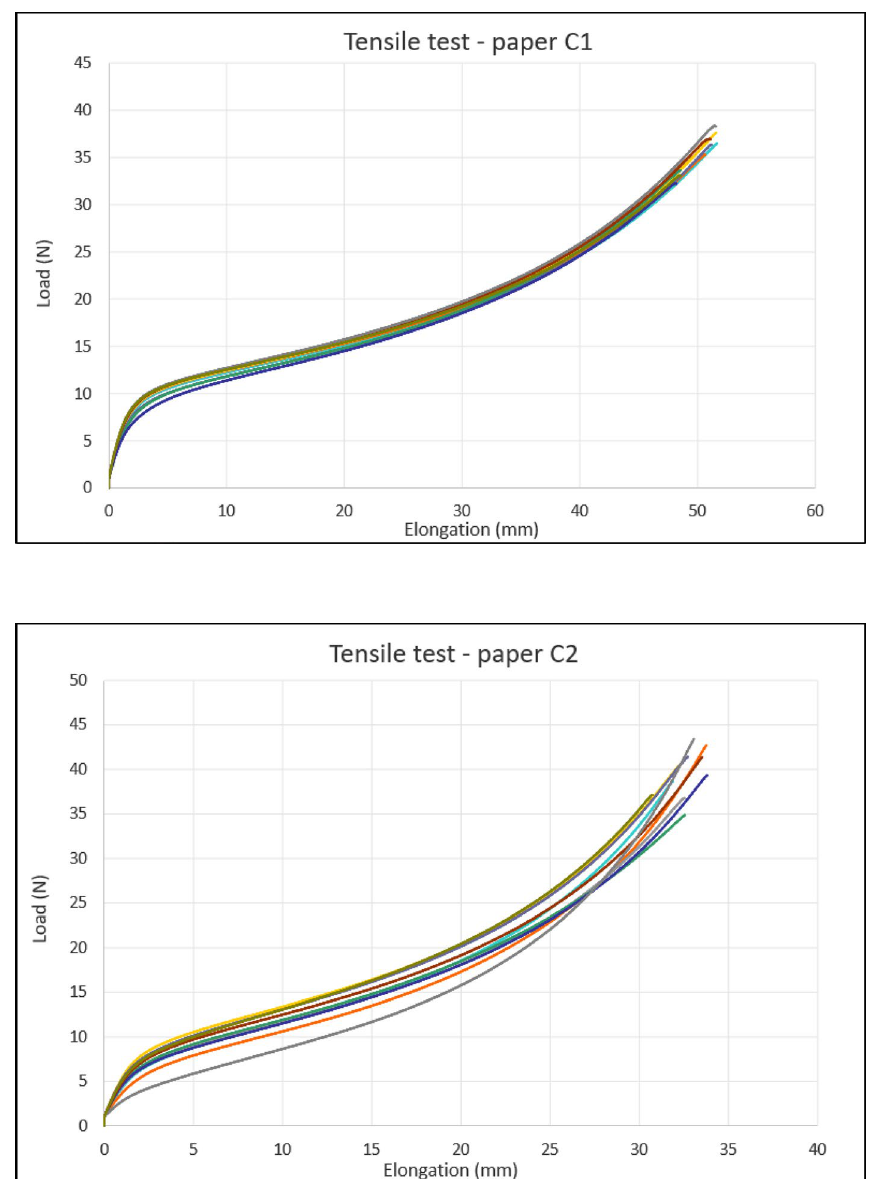
Fig. 26 Force elongation curves of individual specimen of paper C1